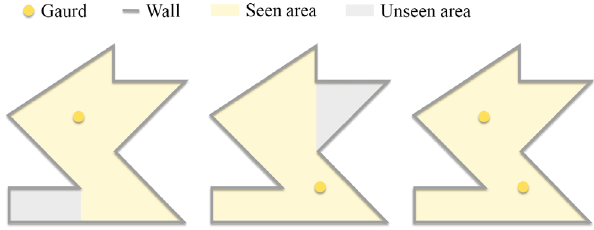
Fig. 10 Art gallery problem: for a polygonal gallery, how many guards are needed to cover the whole